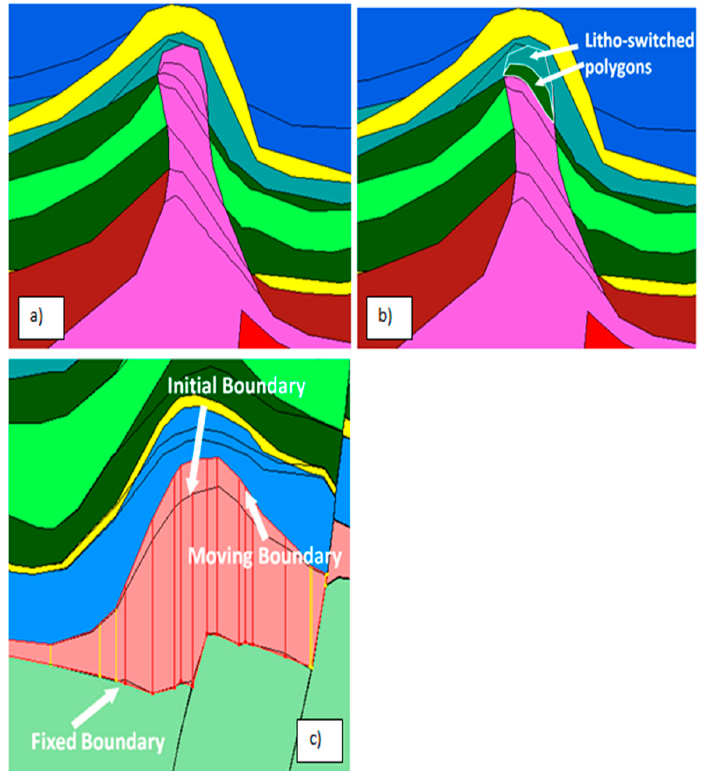
Figure 9. Illustrations of methods for modeling salt movement in the BMT modeling software. ( a , b ) litho-switching. The salt lithology for a polygon is changed at a given time. ( c ) Mass-editing by polygon inflation. The selected vertical in red color, are extended above the upper (moving) boundary while remaining fixed along the lower boundary. Note how overlying polygons are pushed upwards.